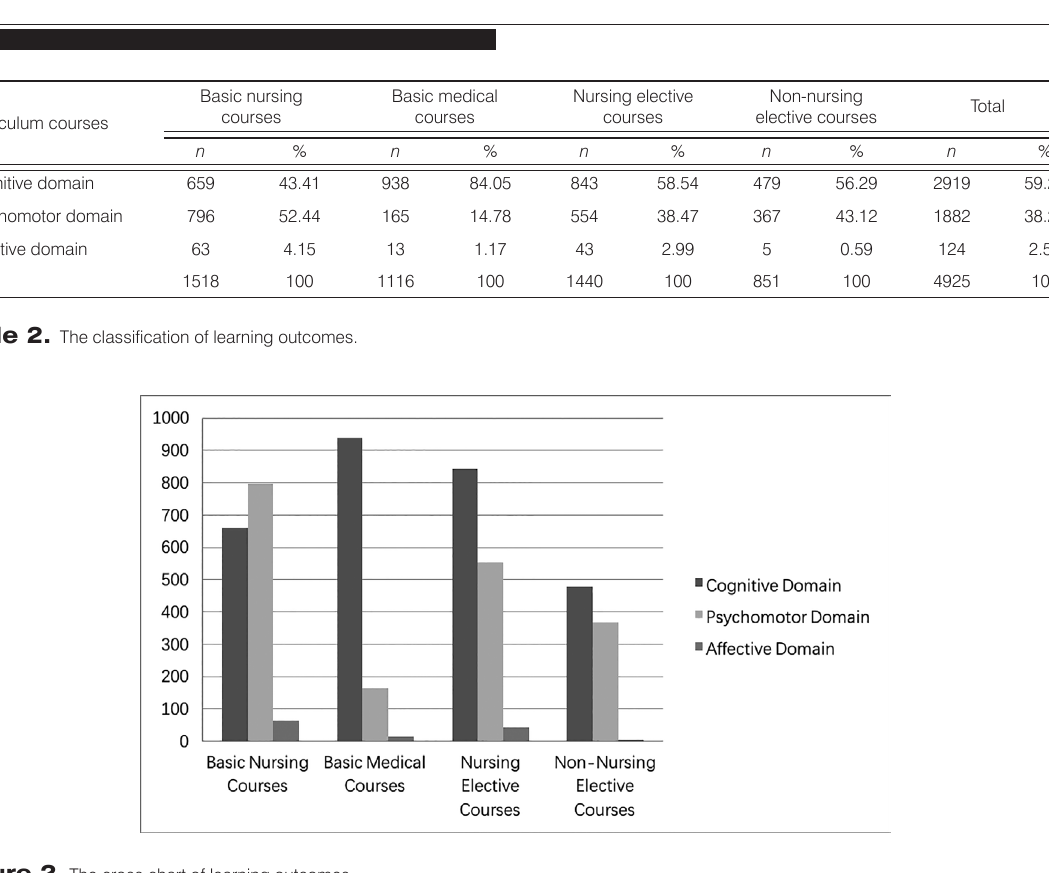
Figure 2. The cross chart of learning